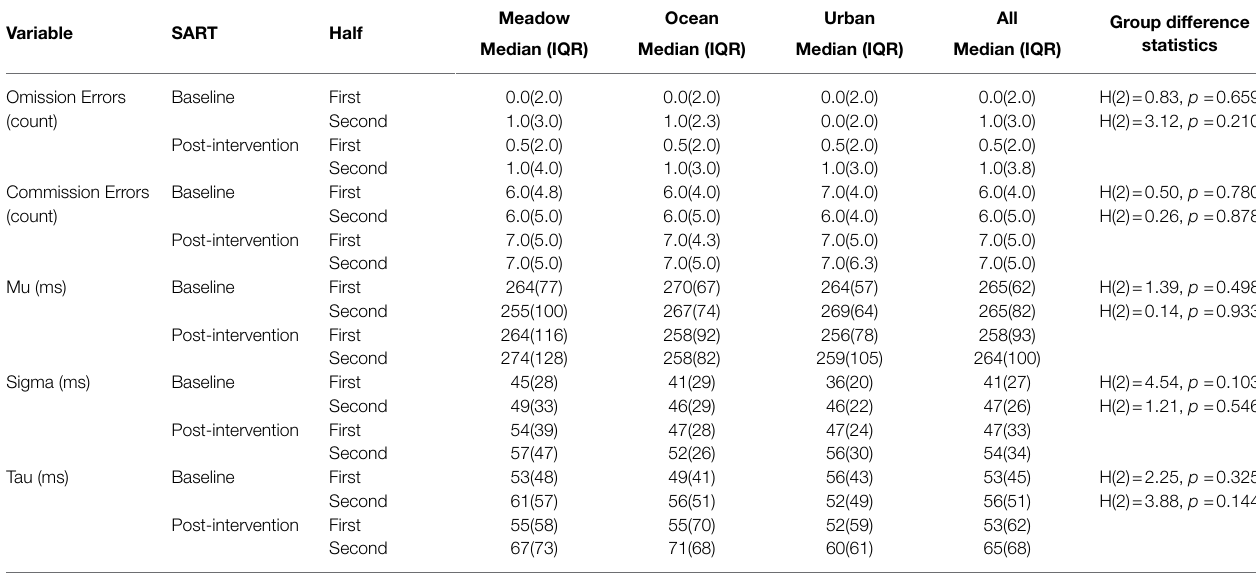
TABLE 5 | Descriptive statistics of each group for the SART variables for Study 2. Variable SART Half